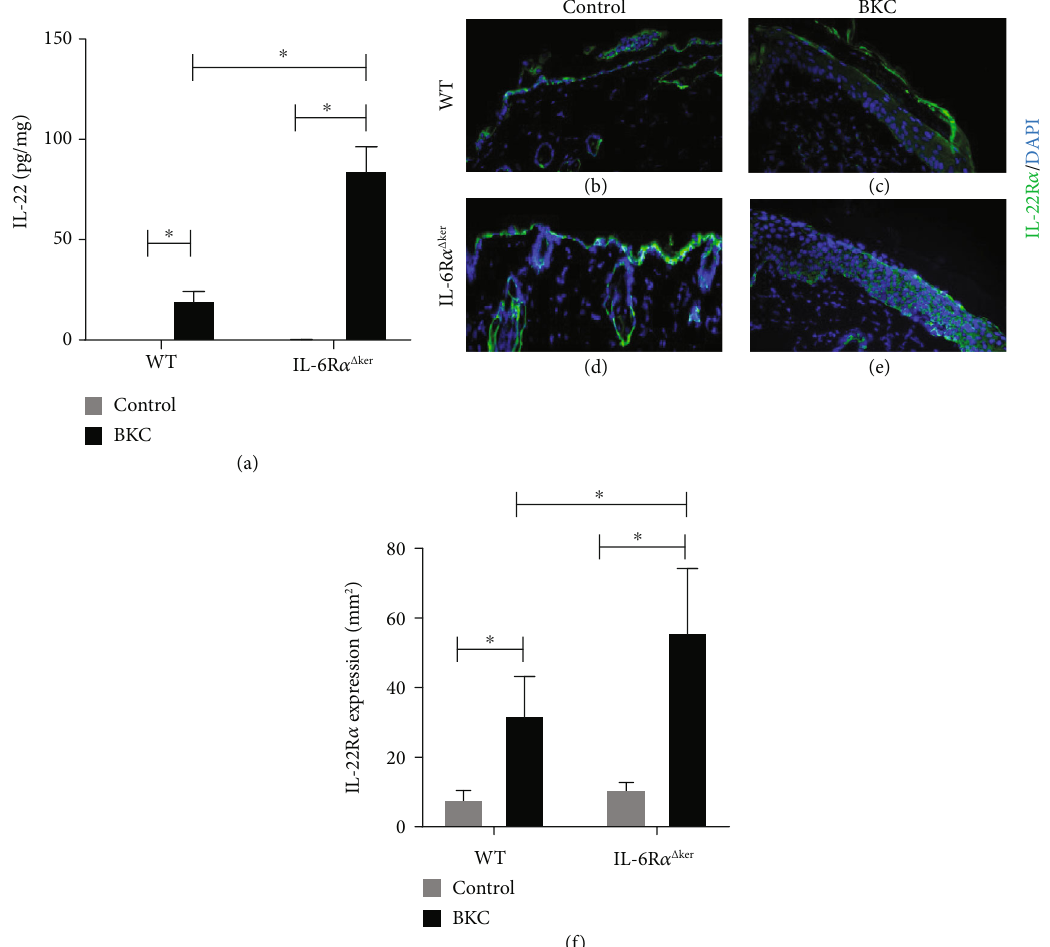
Figure 2: IL-6R α Δ ker mice express higher levels of IL-22R α and IL-22 in lesional skin. Irritants induce higher expression of IL-22 and IL-22R α in mice with a keratinocyte-speci fi c knockout of IL-6R α , IL-6R α Δ ker , and WT mice were exposed to BKC or control for 7 consecutive days. Lesional skin was harvested from each genotype and IL-22 protein expression was determined by Luminex immunoassay (a). Immunohistochemical analysis of lesional skin from irritant-exposed mice, stained for the expression of IL-22R α (green), and nuclear staining DAPI (blue). Representative images from WT (b, c) and IL-6R α Δ ker (d, e). Quanti fi cation of IL-22R α expression as determined by ImageJ (NIH) is presented (f). Data are mean ± SD . ∗ Signi fi cantly di ff erent from WT ( p ≤ 0 : 05 , n = 15